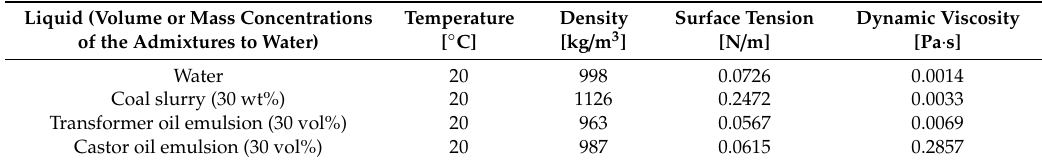
Table 1. Properties of the liquids under study.